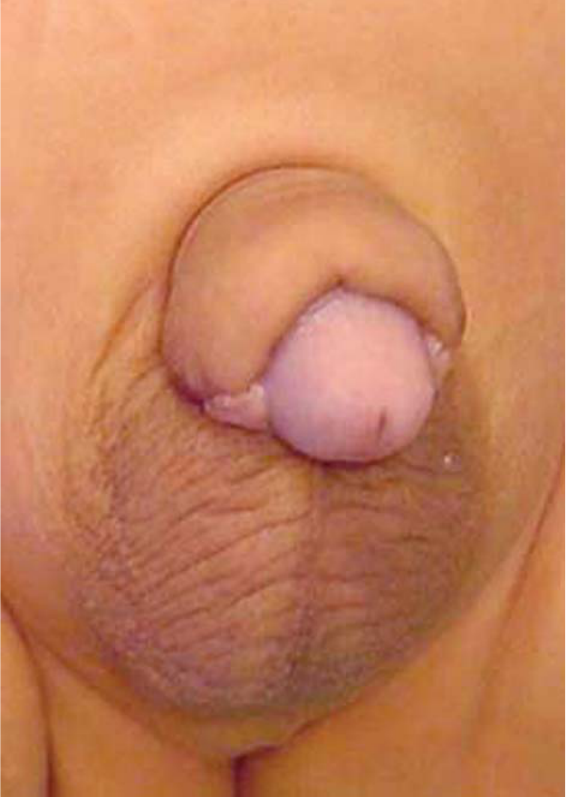
Figure 9 – Postoperative aspect 18 months after surgical cor-